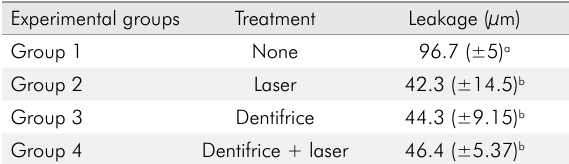
Table 2. Comparison between dye infiltration found in each experimental